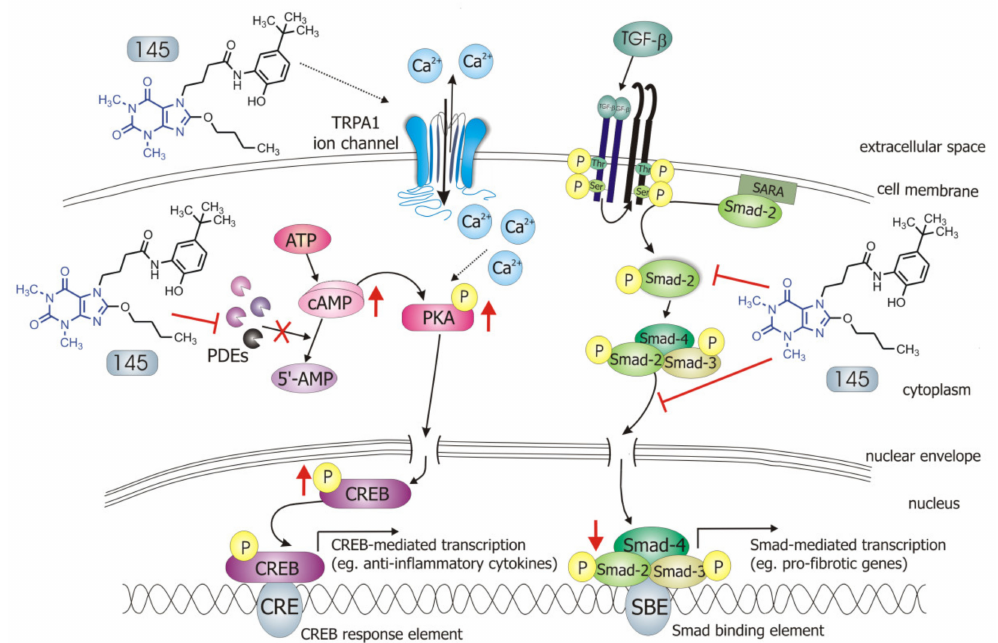
Figure 8. Compound 145 interaction with TGF- β 1 -induced MRC-5 cells and possible targets related to its anti-fibrotic e ff ects. Abbreviations: ATP—adenosine triphosphate; 5 (cid:48) -AMP—5 (cid:48) -adenosine monophosphate; CRE—CREB response element; SBE—Smad binding element, SARA—Smad anchor for receptor